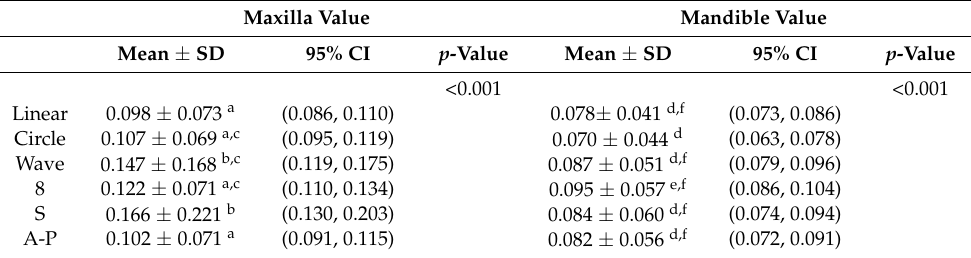
Table 2. Mean absolute deviations of maxilla and mandible buccal-lingual side (mm).